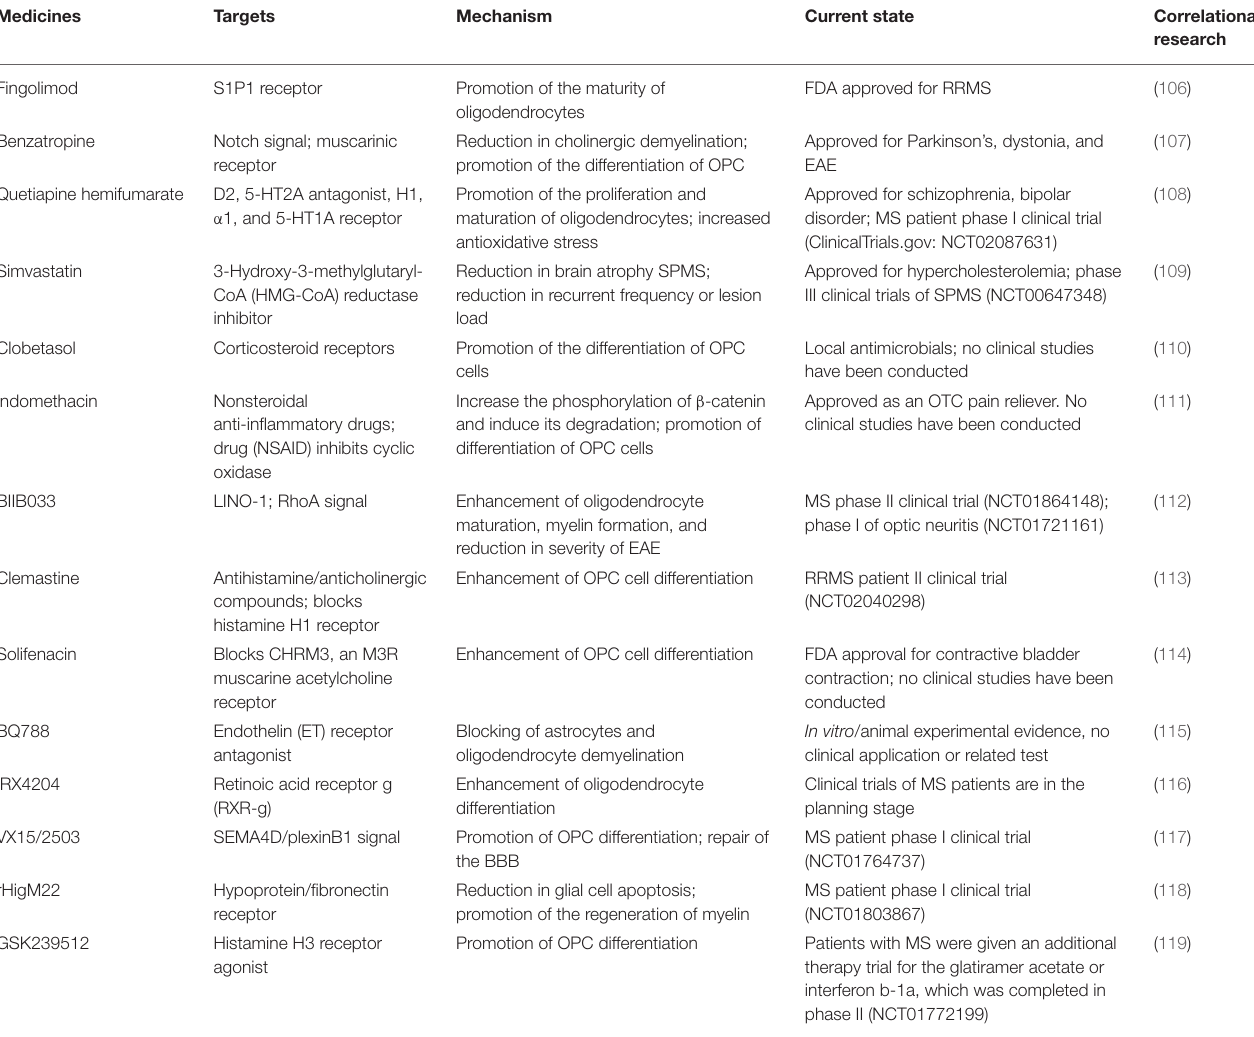
TABLE 1 | Advances in drug research for myelin repair.